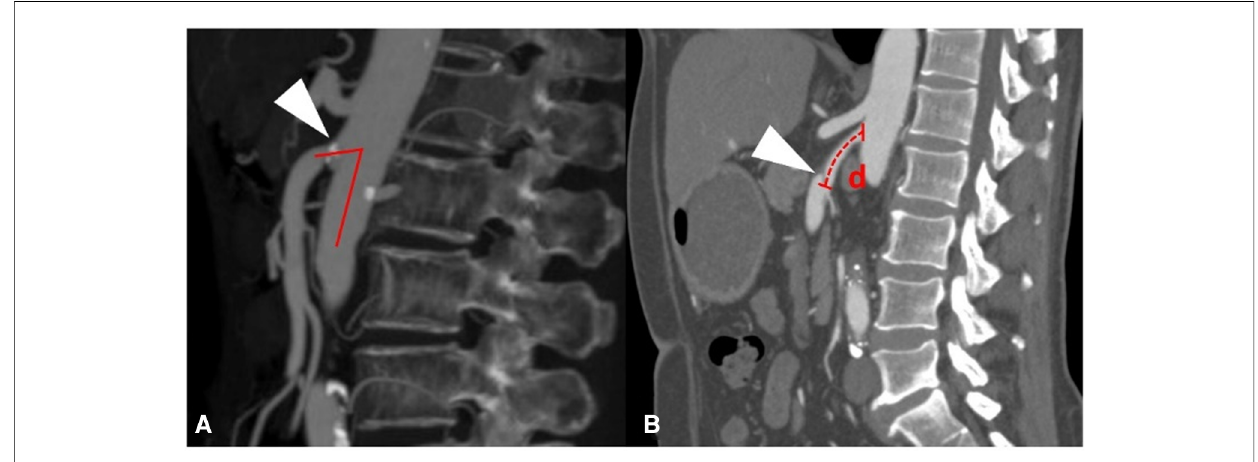
FIGURE 1 Measurements obtained using fi ndings from computed tomography angiography. ( A ) Measurement of the aortomesenteric angle (red lines) and location of the superior mesenteric atherosclerotic plaque (white arrow). ( B ) Measurement of the distance (red d ) from the root of the superior mesenteric artery to the origin of the superior mesenteric artery dissection (white